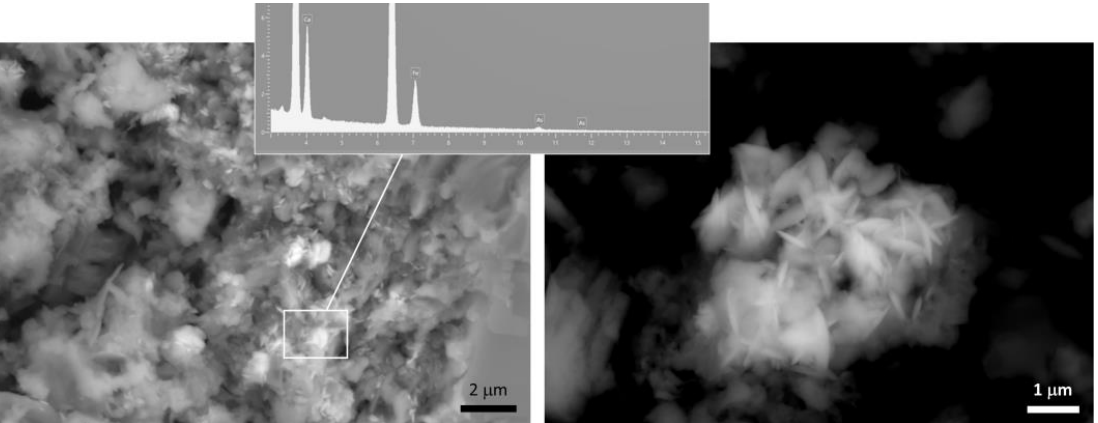
Figure 10. BSE images of sample 3R with corresponding EDS spectrum ( left ), and of a typical platy Fe-oxide/hydroxide particle ( right